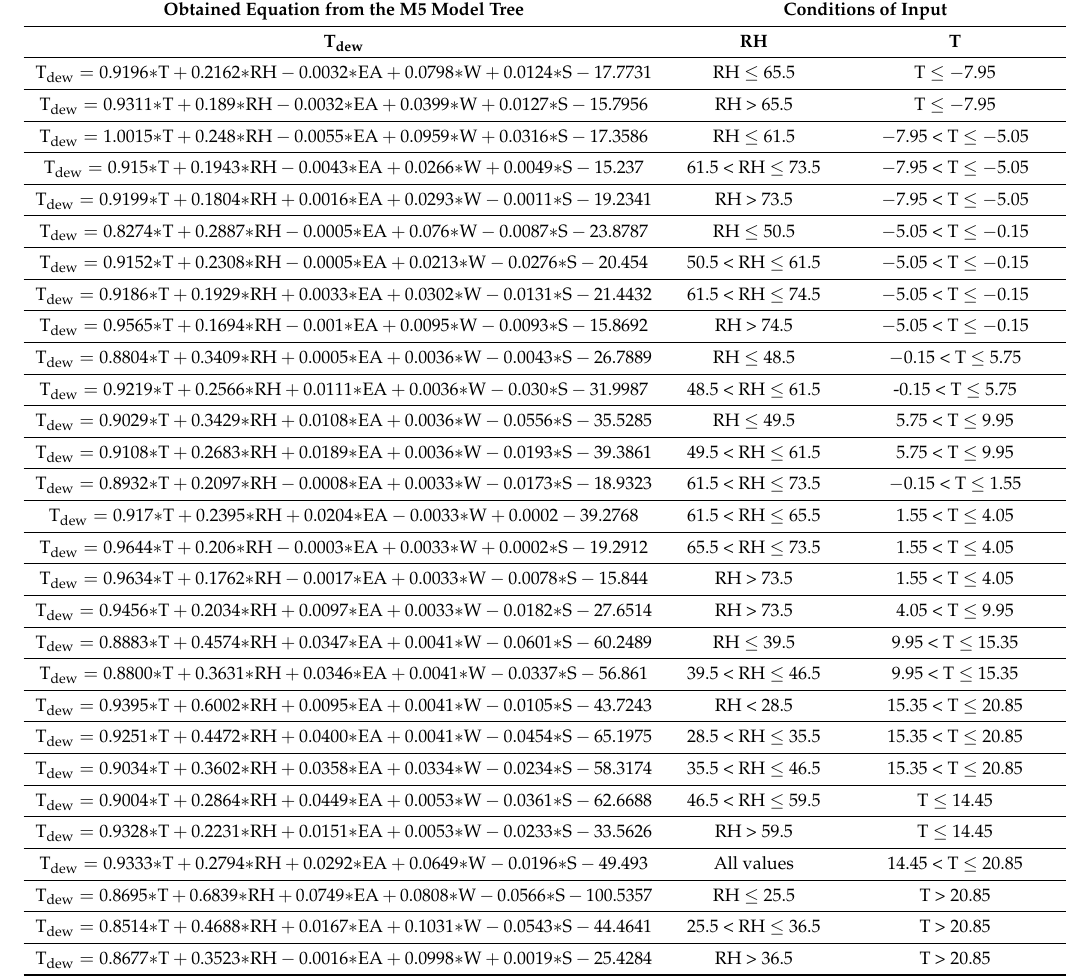
Table 5. Obtained Equation from the M5 model tree for scenario No.